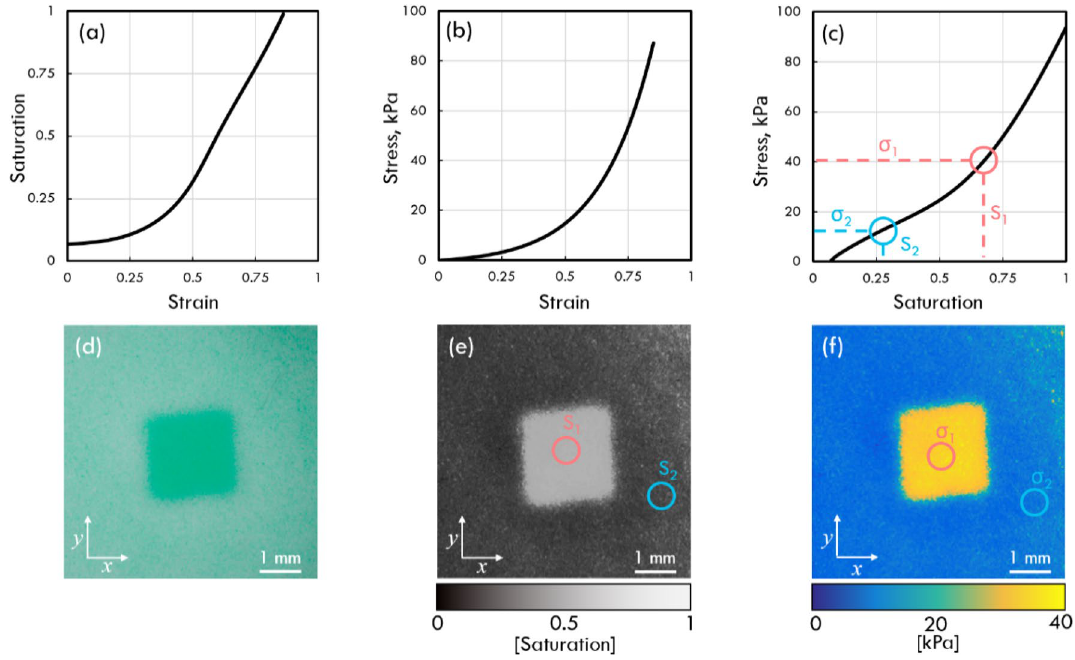
Figure 3. Layer characterisation and generation of optical palpograms. ( a ) The saturation-strain characterisation curve, ( b ) the stress–strain characterisation curve of the micro-porous silicone layer and ( c ) the resulting stress-saturation curve. ( d ) Digital photograph of micro-porous layer of phantom containing a 2.5 × 2.5 mm inclusion phantom at 50% preloaded strain, and ( e ) the corresponding colour saturation image where the red and blue circles represent the relative colour saturation through a region of the inclusion and base, respectively. ( f ) The optical palpogram is produced by equating each pixel in ( e ) to a stress value using the stress–strain curve in ( c